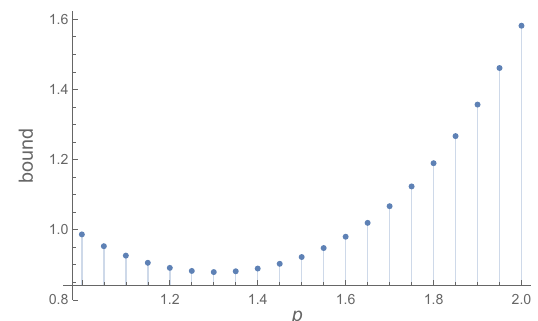
FIG. 3. The upper bound on the error in the adiabatic evolution as a function of p used in the scheduling function f ( s ) . In this plot, we use constant values κ = 40 and T = 10 5 .